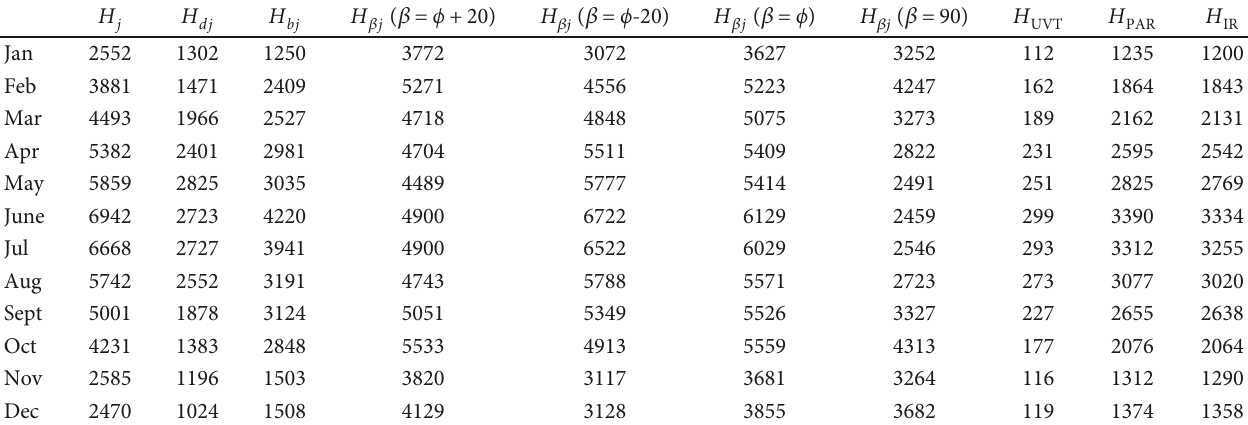
Table 9: Representative year monthly averages of various solar radiation component daily values (Wh/m 2 ).